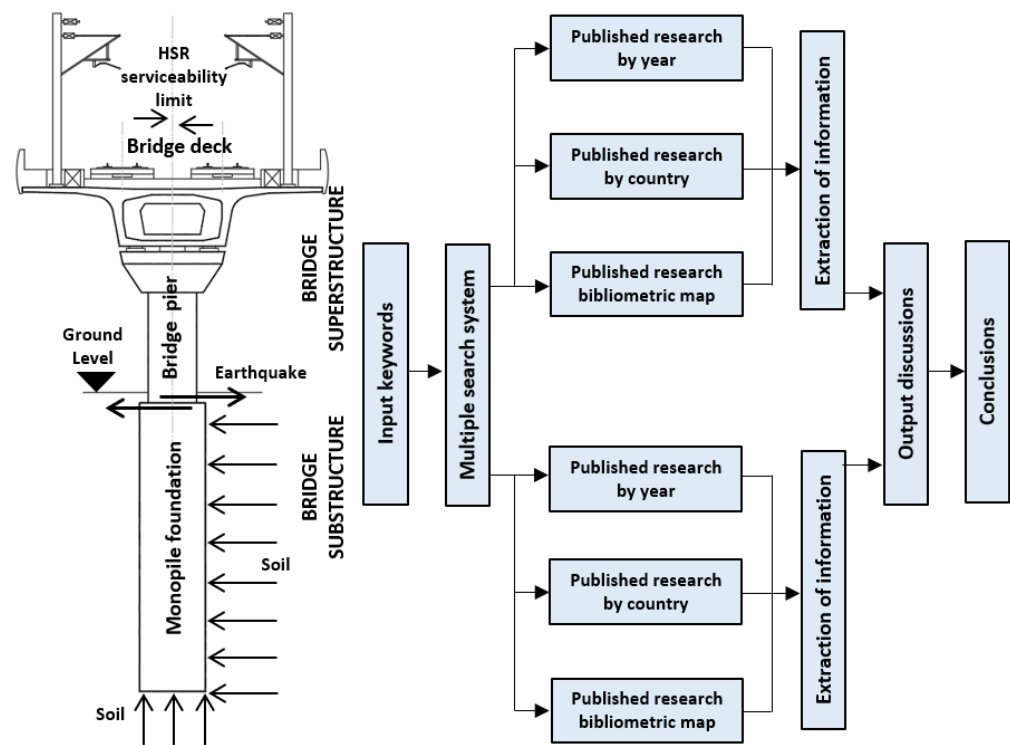
Figure 3. Sequence of the bibliometric review.